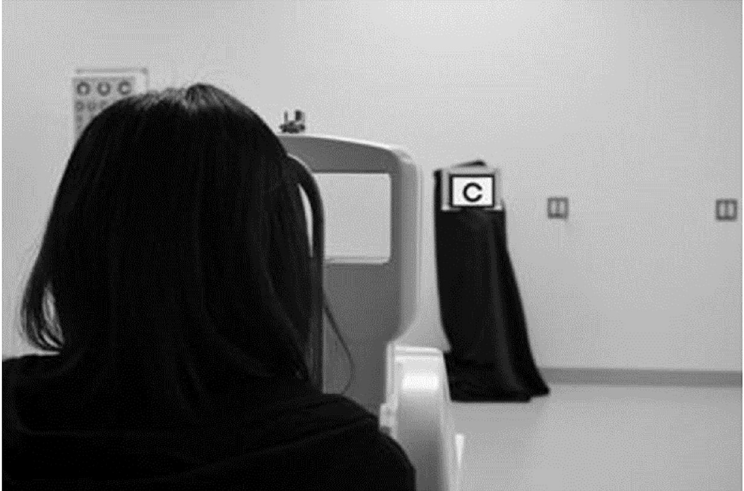
Fig 1. Experimental scene in lightroom (measurement with a binocular open auto refractometer). A luminance- adjustable tablet terminal is set up at a distance of 5 m in front of the eyes of the research participants, presenting the Landolt rings, and measuring the subjective and objective refractive